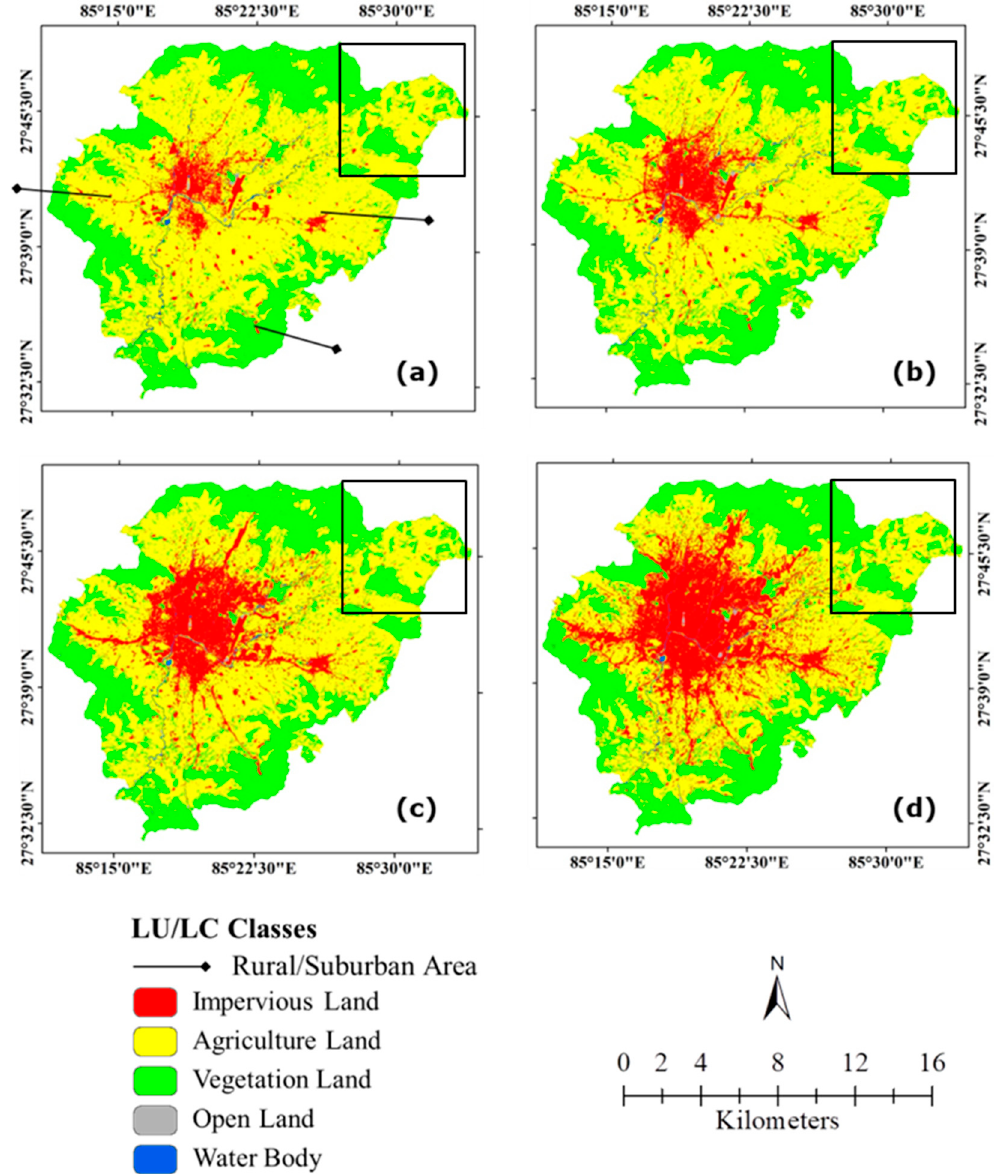
Figure 2. Spatial dynamics of Land Use / Land Cover (LULC) in Kathmandu, ( a ) 1988; ( b ) 1998; ( c ) 2008; ( d ) 2018. Square box transect over all LULC maps (a–d) is to show the effects of Agriculture land on land surface temperature (LST) dynamics.